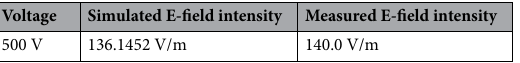
Table 5. Electric field intensity summary.